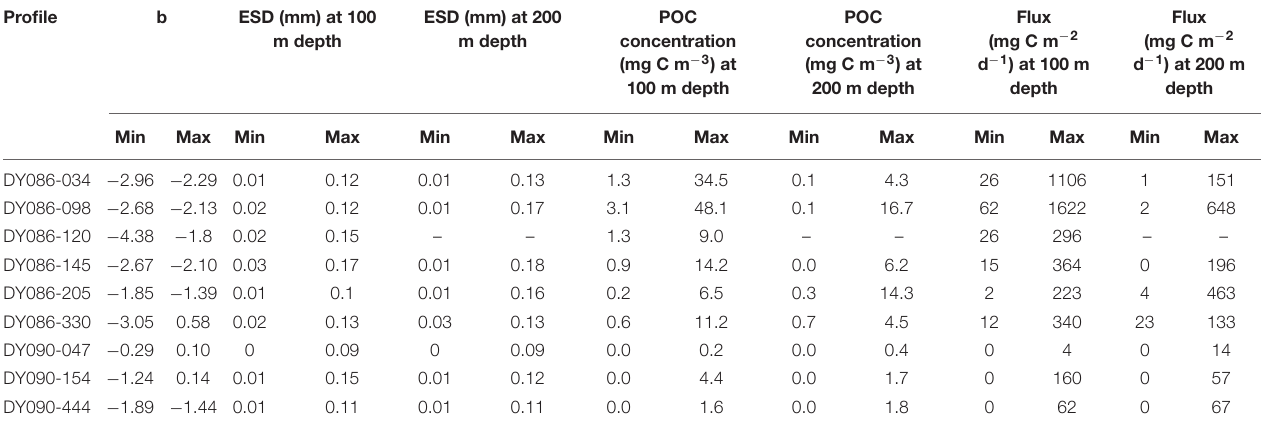
TABLE 5 | Variability of particle characteristics at all stations based on vertical profiles.